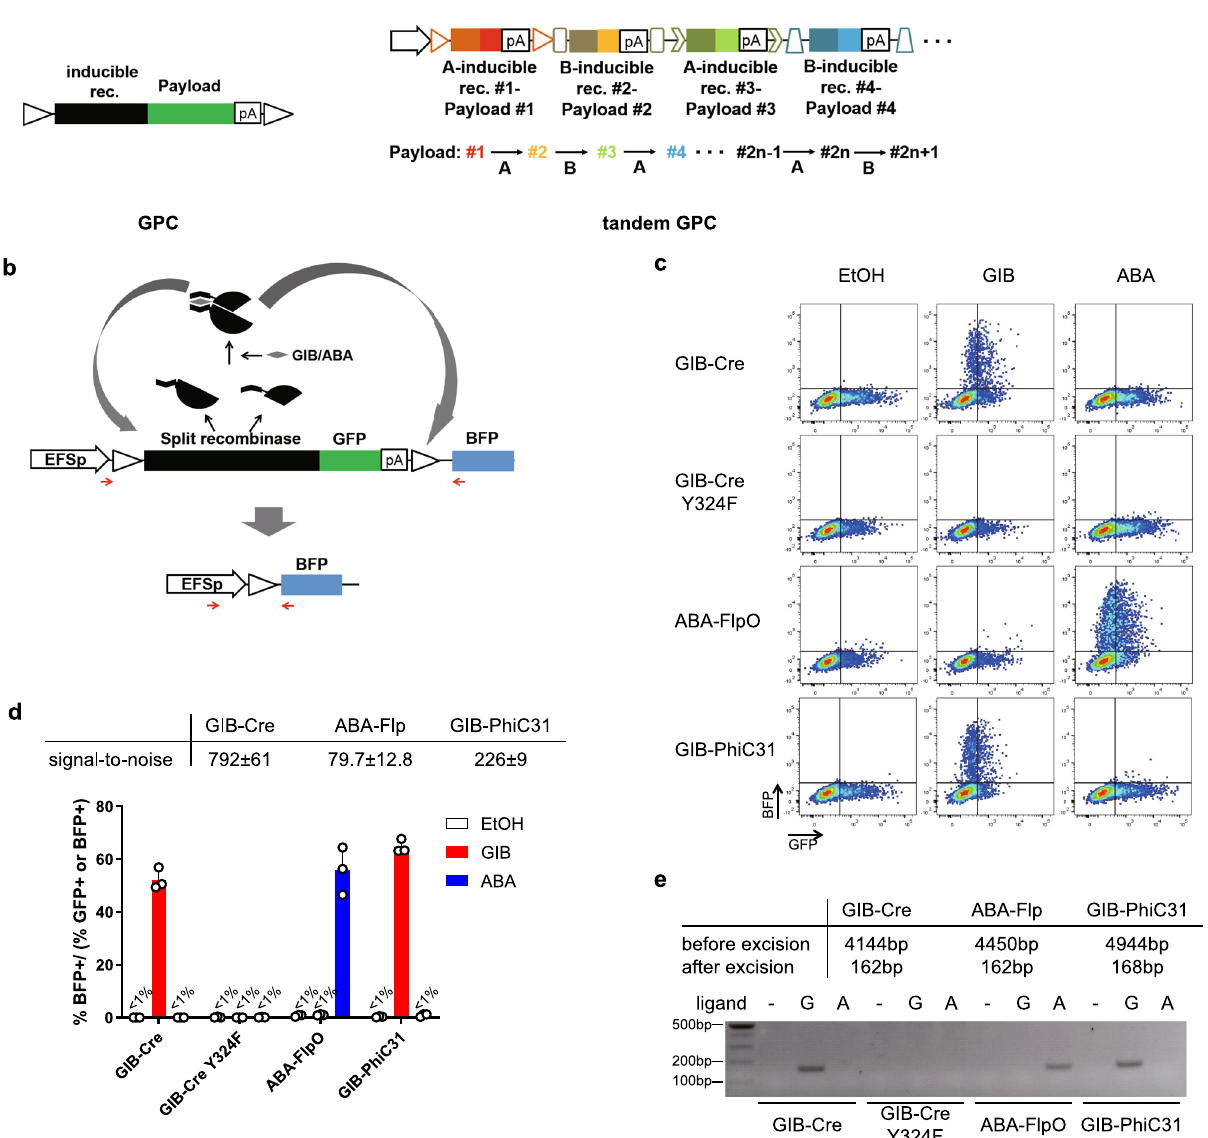
Fig. 1 Design and validation of the gene perturbation cassette (GPC). a Schematics of a single-unit GPC (left) and the tandem GPC circuit for programming gene expression cascades (right). b A single GPC enables the switching of the expressed gene from GFP to BFP. Red arrows indicate the primers used to detect the excision event in e . EFSp: human EF1a short promoter. c Representative fl ow cytometry plot for cells transfected with the single GPC architecture described in b , implemented with the indicated split recombinase and treated with the indicated ligands for 24 h. d Quanti fi cation of the results in c ( n = 3, mean ± s.d.). %BFP + /(%BFP + or GFP + ) indicates the fraction of cells that had undergone recombination. e PCR validation of excision upon ligand treatment using primers depicted as red arrows in b . Source data are provided as a source data fi le. G: GIB, A: